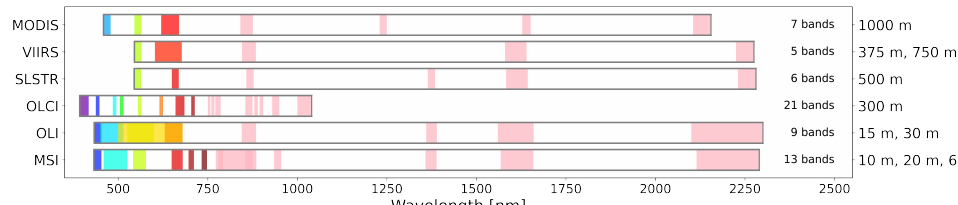
Figure 3. The reflective bands within the electromagnetic spectrum listed per sensor that were used within this paper as input data by LAMSU. The total number of reflective bands is given on the far right. The bands’ approximate ground resolution that is available for download is indicated by the second